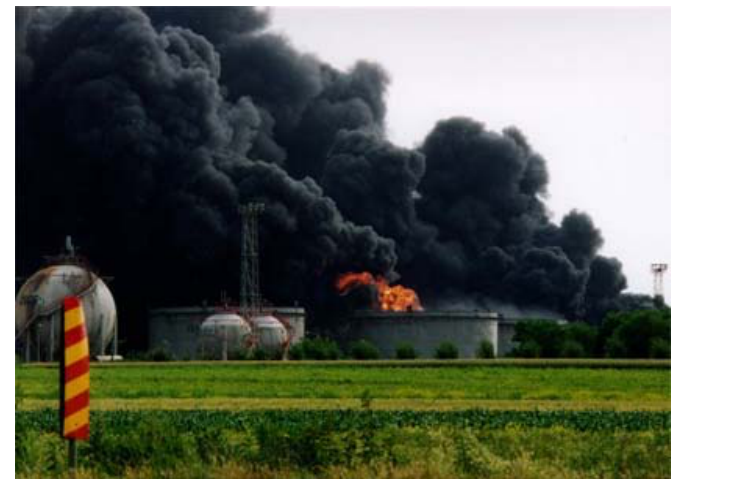
Figure 2 – Fire on the spherical reservoirs of vinyl chloride monomer in Pancevo Рис . 2 – Пожар в сферических резервуарах мономера винилхлорида в г . Панчево Слика 2 – Пожар на сферним резервоарима мономера винил хлорида у